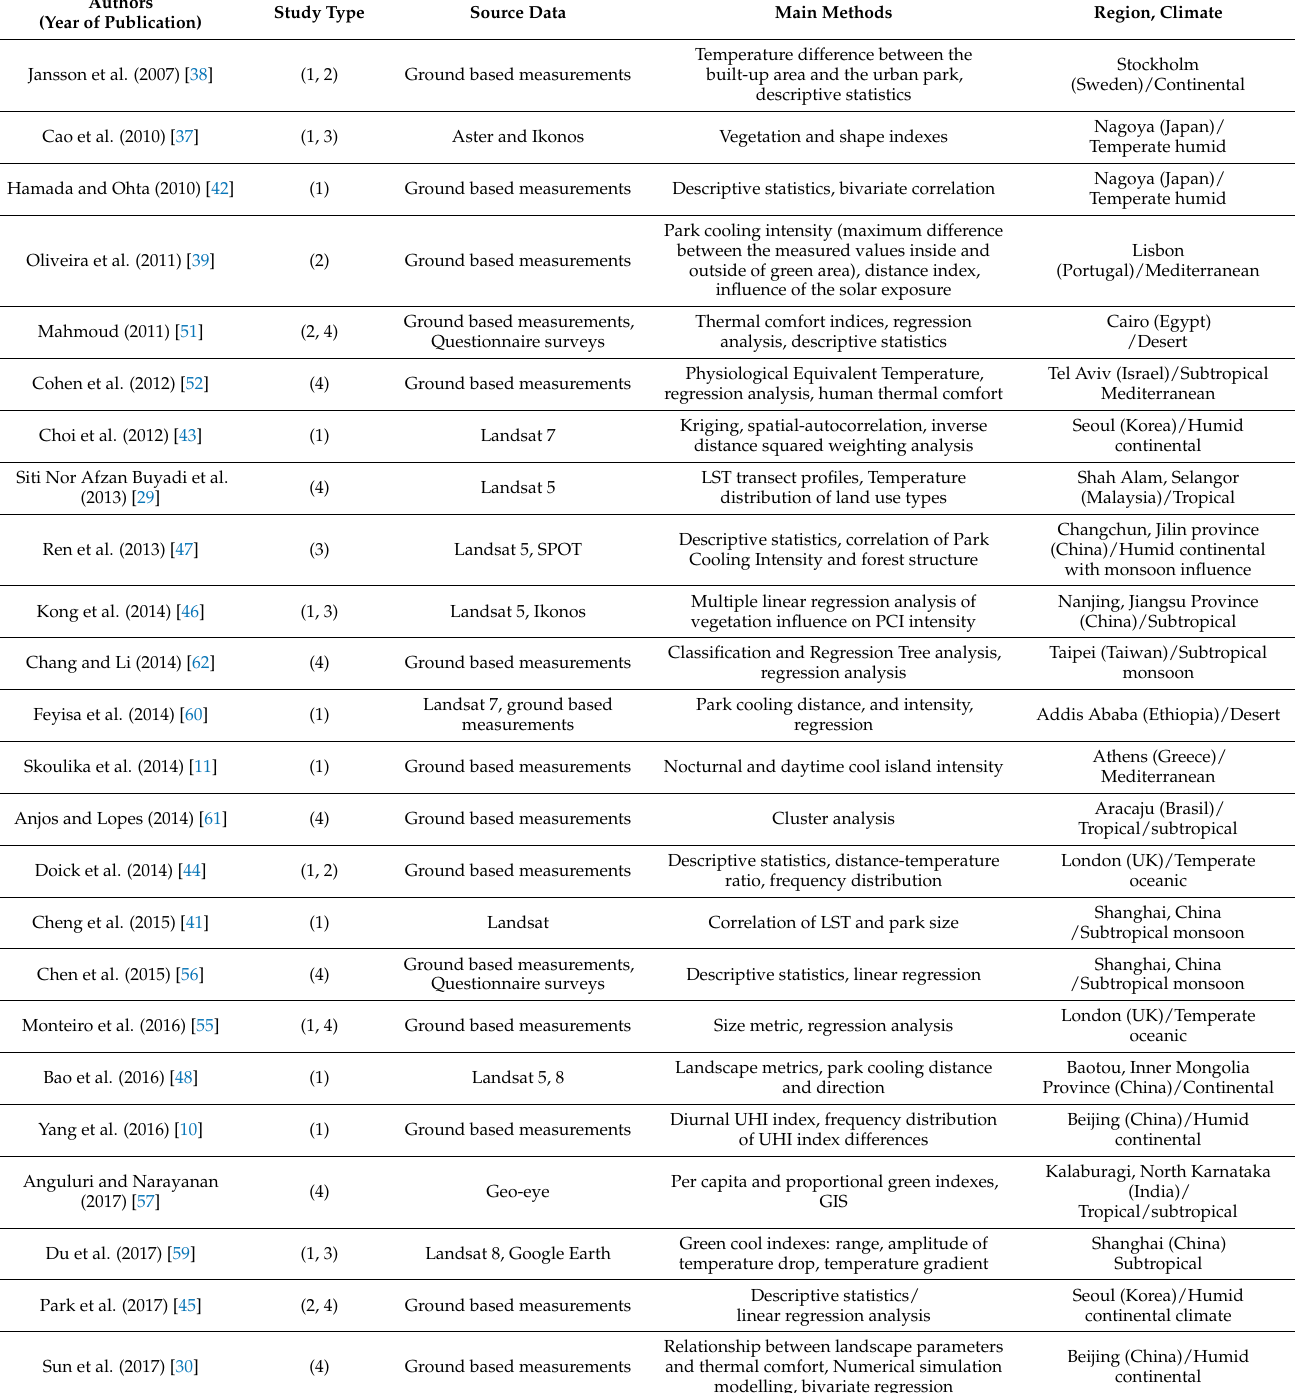
Table A1. Selected recent studies of urban park cooling effect in chronological